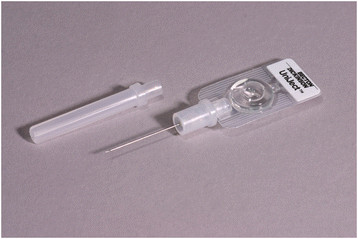
The oxytocin in UnijectTMinjection system. Source: PATH/Glenn Austin.